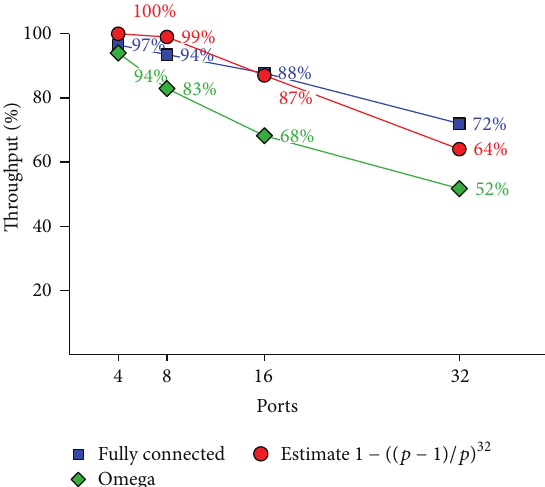
Figure 14: The effect of varying the number of ports on throughput of the random memory access benchmark on the small resource memories.